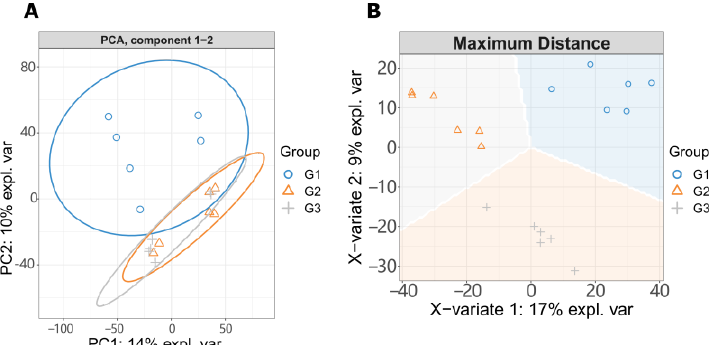
Figure 3. LC-MS/MS detected ions analysis. ( A ) PCA analysis. G1, tomato seeds soaking in water; G2, tomato seeds treated with 10 μg/L LGC; G3, tomato seeds treated with 100 μg/L LGC. ( B ) sPLS- DA analysis.